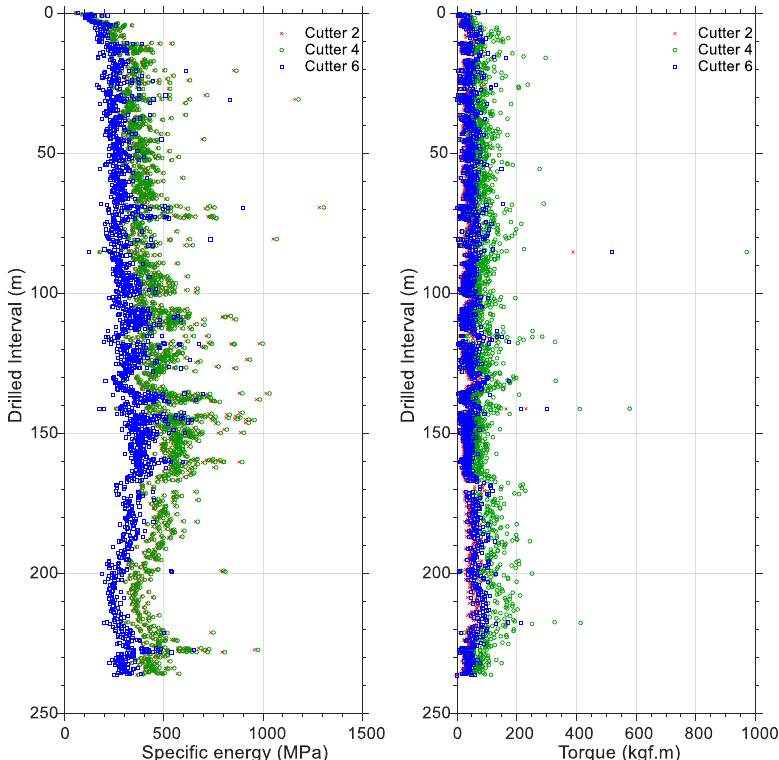
Figure 18. Specific energy ( left ) and torque ( right ) plots at the bit during bit run number 2.